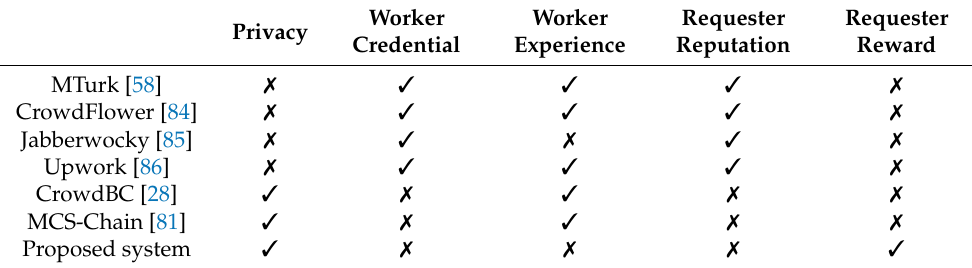
Table 2. Comparison of proposed system with existing crowdsourcing